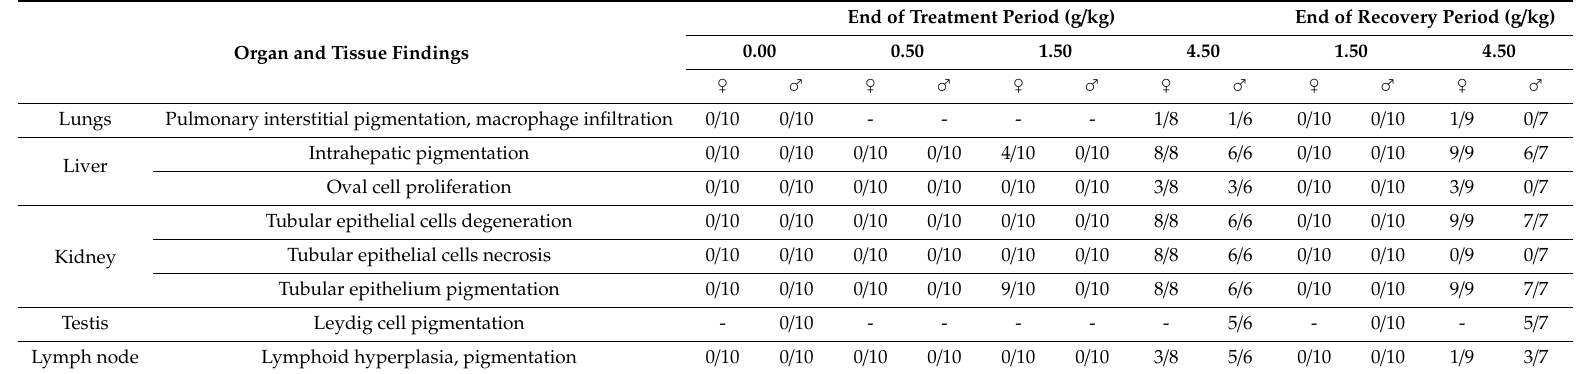
Table 4. Histopathological findings of S-D rats orally administered with gardenia yellow for 90